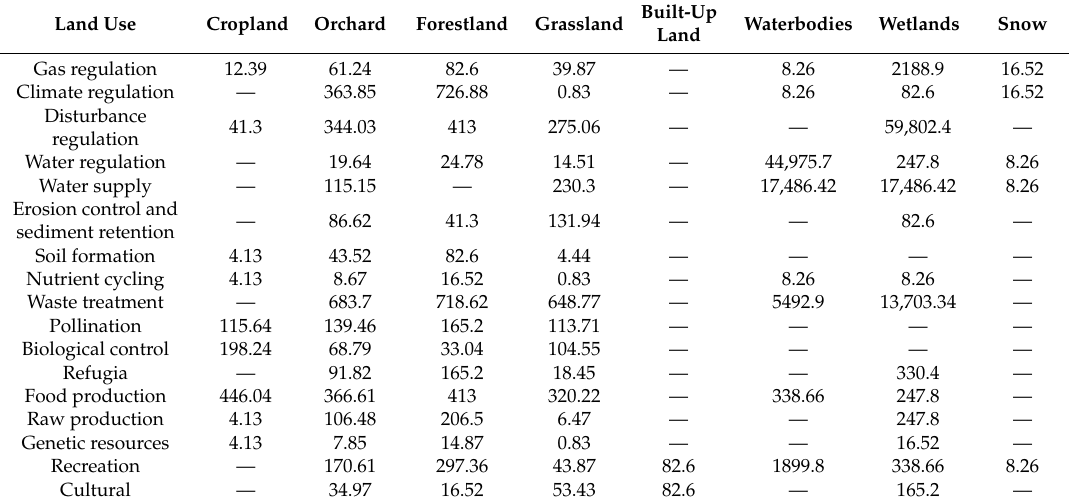
Table 2. ESV per unit area of different land use types (unit: yuan · (hm 2 · a) − 1 ).